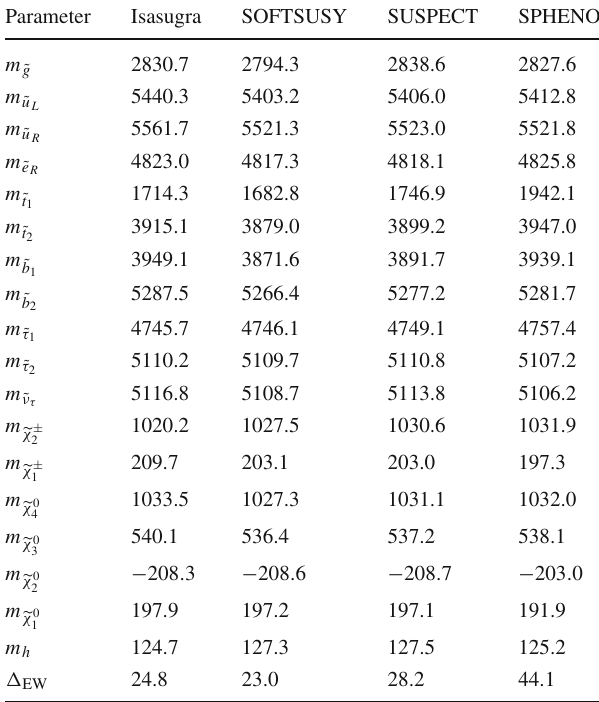
Table 1 Sparticle and Higgs mass spectra from four spectra generators for a natural SUSY benchmark point with m 0 = 5 TeV, m 1 / 2 = 1 .